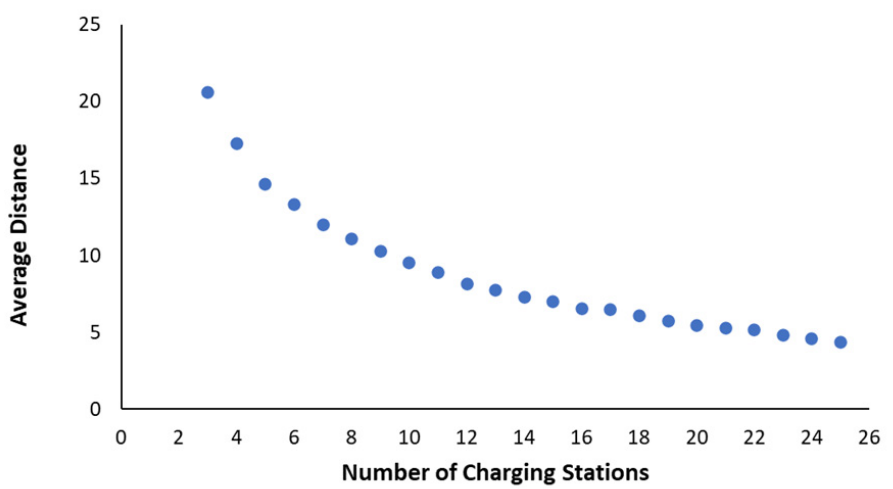
Figure 4. Trade-off diagram between the number of charging stations and the average EV travel distance.